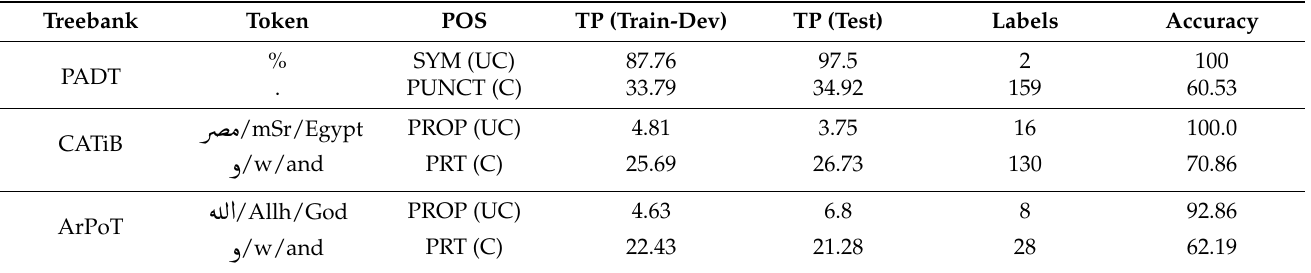
Table 15. Most frequent tokens for common and uncommon POS tags in the corpora. TP: token ratio of POS tag; C: common; UC: